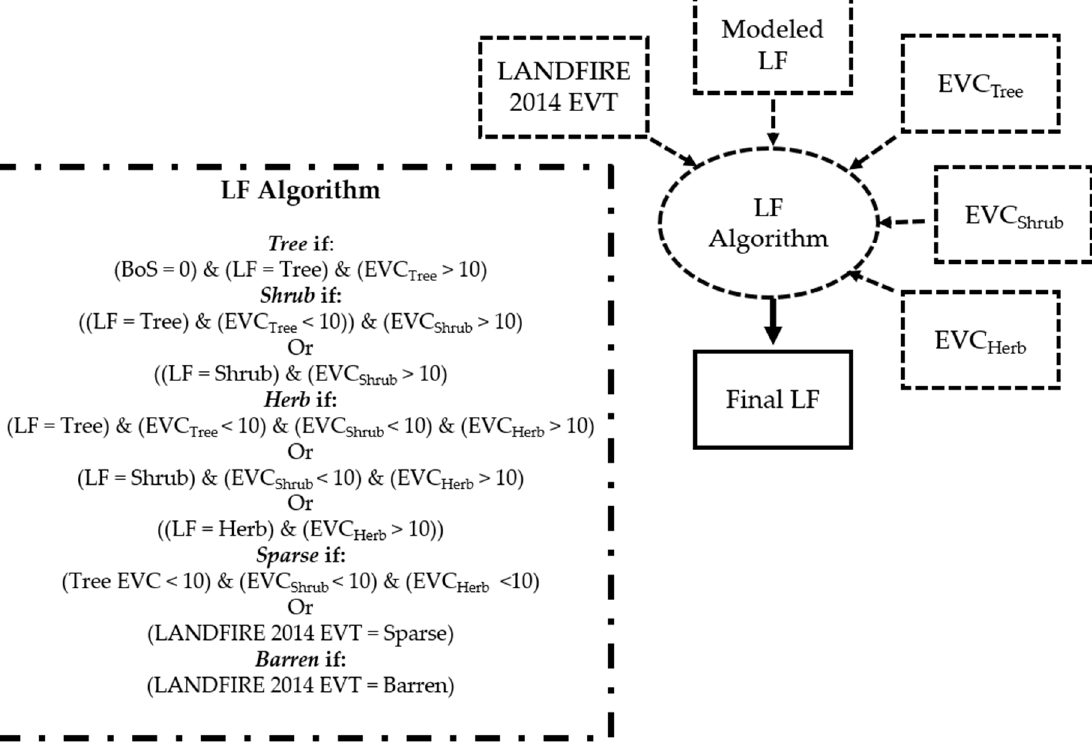
Figure 6. Flowchart and algorithm logic for the creation of the LANDFIRE Remap prototype lifeform using the modeled lifeform (LF), LANDFIRE 2014 EVT (barren or sparse), and the tree, shrub, and herb Existing Vegetation Cover (EVC) datasets (e.g., EVC Tree ).